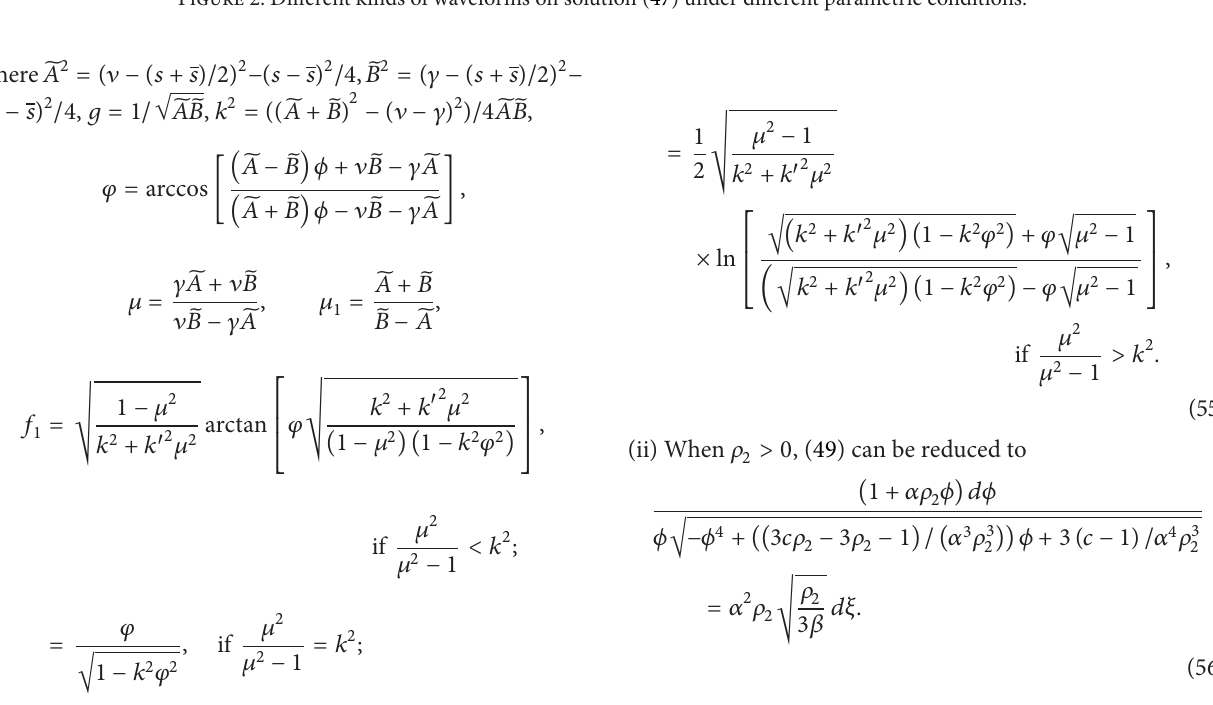
Figure 2: Different kinds of waveforms on solution (47) under different parametric